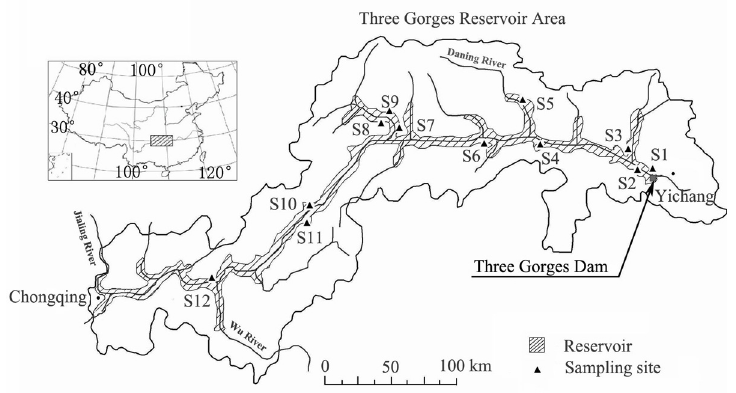
Fig 1. Spatial distribution of the twelve sites sampled in 2010. The sites sampled in 2009 were mostly the same and were mapped previously [13]. The Three Gorges Reservoir Area is a combination of all the counties around the reservoir. Modified from [13] with permission from Polish Journal of Ecology .